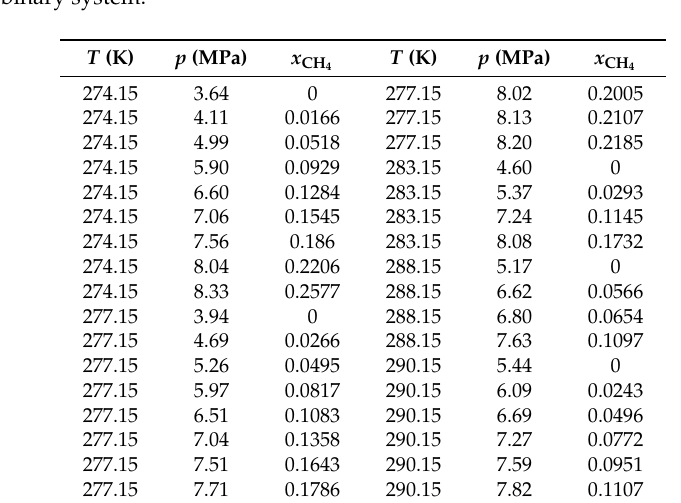
Table 4. Experimental measurements of bubble points (molar fraction of CH 4 in the liquid phase) on the CH 4 -CO 2 binary system.